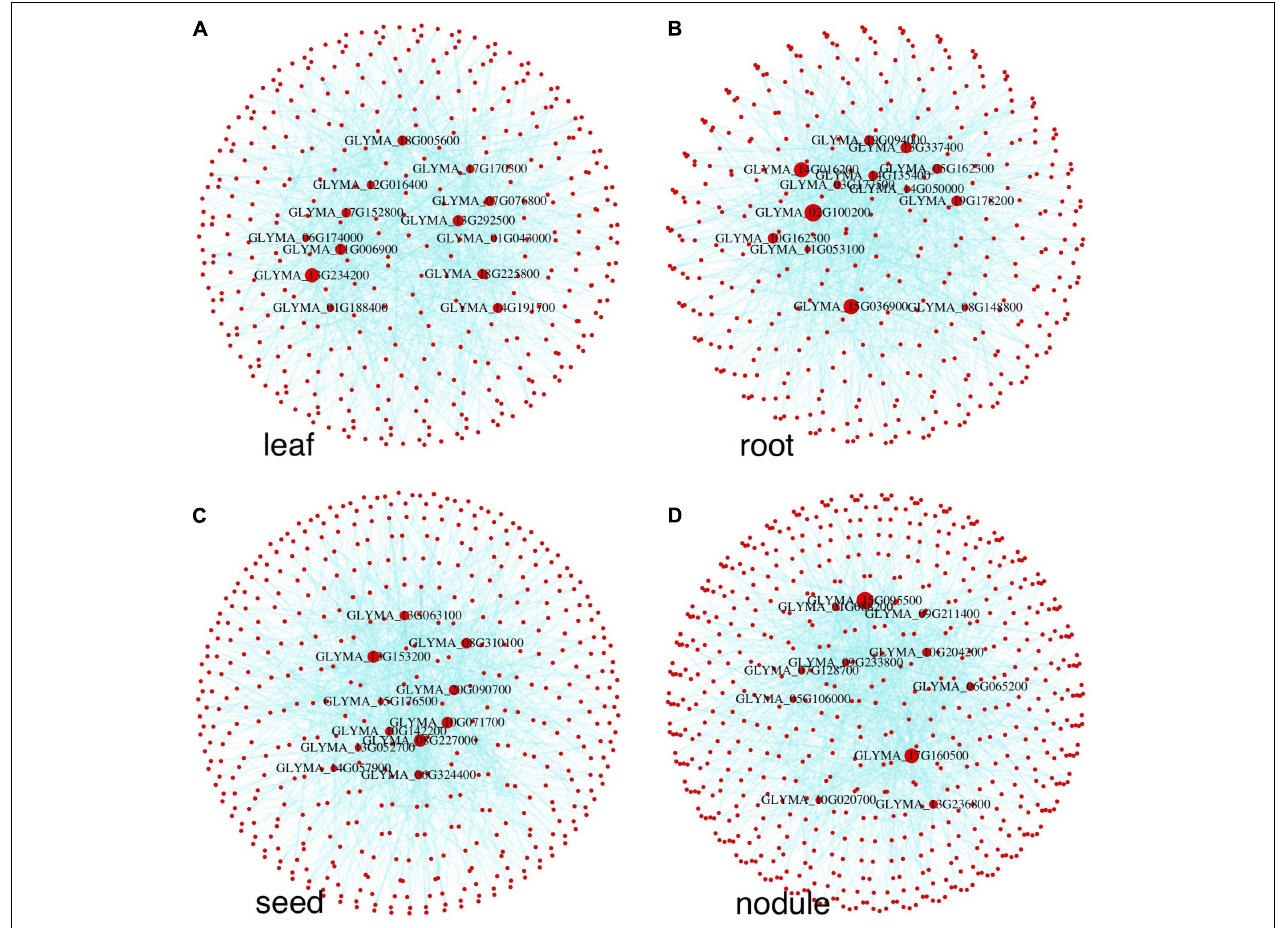
FIGURE 5 | Tissue-specific GRNs of leaf, root, seed, and nodule. Red nodes represent genes, blue lines represent regulatory edges. Key regulatory genes are marked by the corresponding gene names. The node size is proportional to the node degree; thus, the bigger the node, the higher the node degree